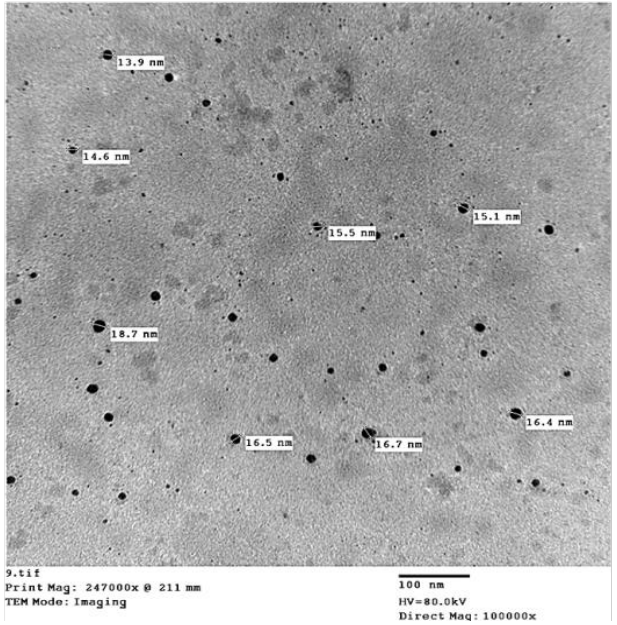
Figure 4. Phosphorus nanoparticles.